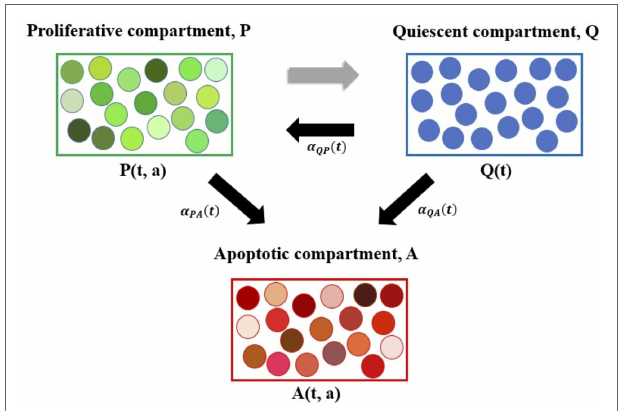
FIGURE 1 | Diagram representing the age-structured mathematical modeling framework. Here, P denotes the proliferative compartment, with P ( t , a ) cells present at time t with time a remaining to be spent in this compartment. Proliferative cells can either transition to A or to Q at a = 0 upon completion of the cell cycle. Q denotes the quiescent compartment, with Q ( t ) cells present at time t . Quiescent cells can either transition to P with rate (cid:11) QP ( t ) or to A with rate (cid:11) QA ( t ). A denotes the apoptotic compartment, with A ( t , a ) cells present at time t and time a remaining to be spent in this compartment before completing apoptosis. For illustration purposes, cells within each compartment are grouped together. The various shades of green represent the different times remaining to be spent by cells in the proliferative compartment (i.e., in the cell cycle) before transitioning. Similarly, the various shades of red represent the different times remaining to be spent by cells in the apoptotic compartment, before completing apoptosis and being removed from the numerical simulations. The three explicit transition rates (i.e., (cid:11) QP ( t ), (cid:11) PA ( t ), and (cid:11) QA ( t )) are illustrated using black arrows pointing in the direction of the respective transition. The implicit transition from P to Q representing the successful completion of the cell cycle is denoted by a gray